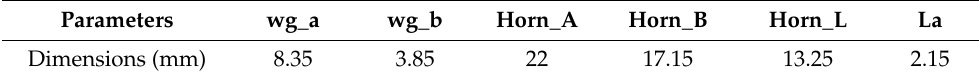
Table 5. Dimensions of 3D-printed horn antenna using conductive filament.